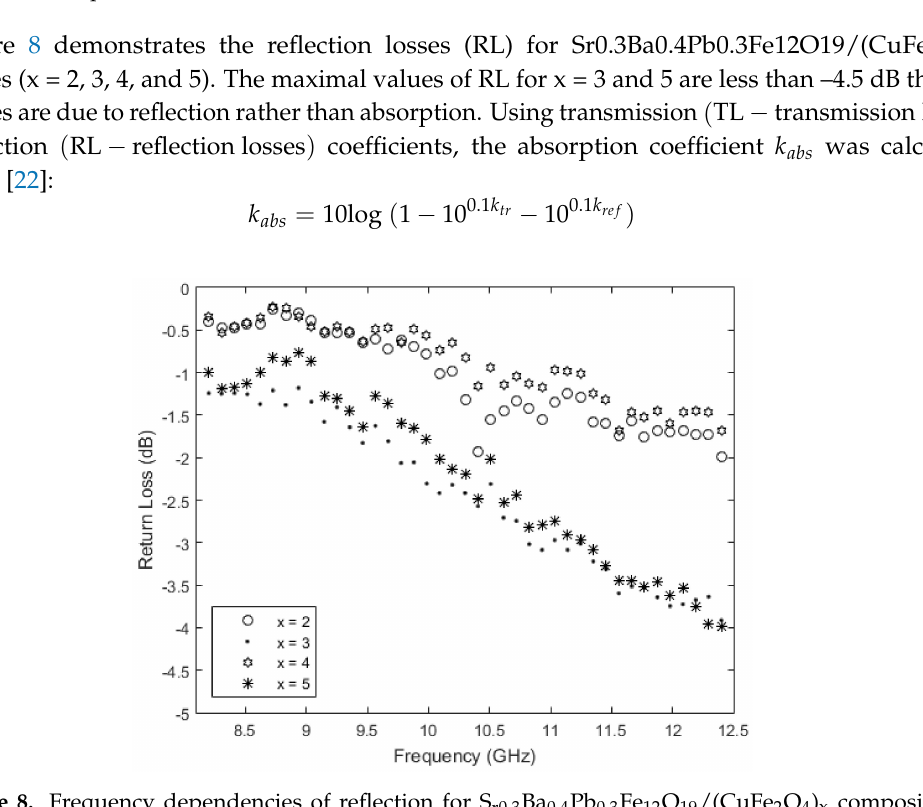
Figure 7. Frequency dependencies of ( a ) S11 and ( b ) S21 parts for S r0.3 Ba 0.4 Pb 0.3 Fe 12 O 19 /(CuFe 2 O 4 ) x composite samples (x = 2, 3, 4 and 5).